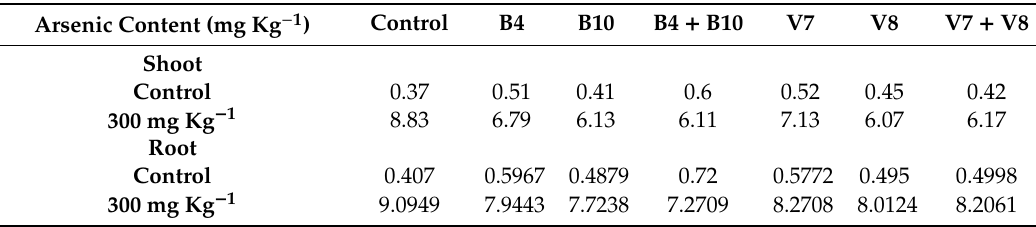
Table A1. Arsenic content (mg · Kg − 1 ) in the shoot and root of Triticum aestivum without the addition of As and the addition of 300 mg · Kg − 1 of As. Control: no inoculation of microorganisms; P. gessardii (B4), B. intermedia (B10), the mixture of both (B4 + B10), F. rabenhortii (V7), H. viticola (V8), and the mixture of both (V7 +